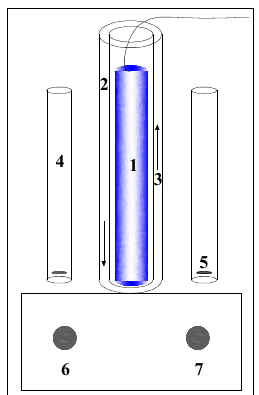
Figure 1. The schematic diagram of the experiment setup: (1) low-pressure Hg UV lamp, (2) quartz tube, (3) cooling water, (4) photoreactor, (5) magnetic stirrer, (6) magnetic stirrer apparatus, (7) thermostat.